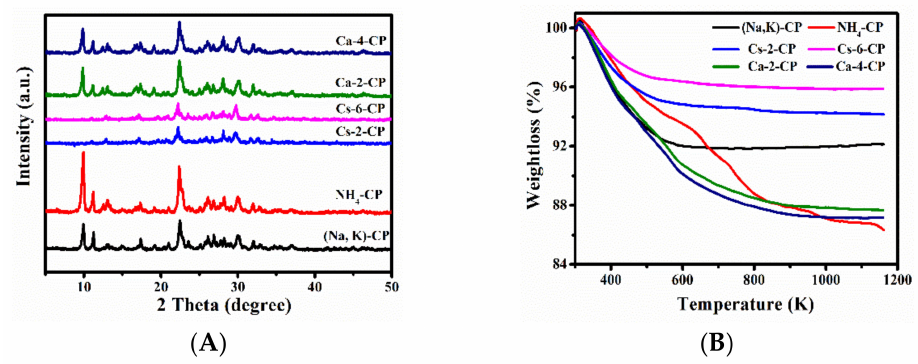
Figure 1. XRD patterns ( A ) and TG profiles ( B ) of (Na, K)–CP of various ion-exchanged